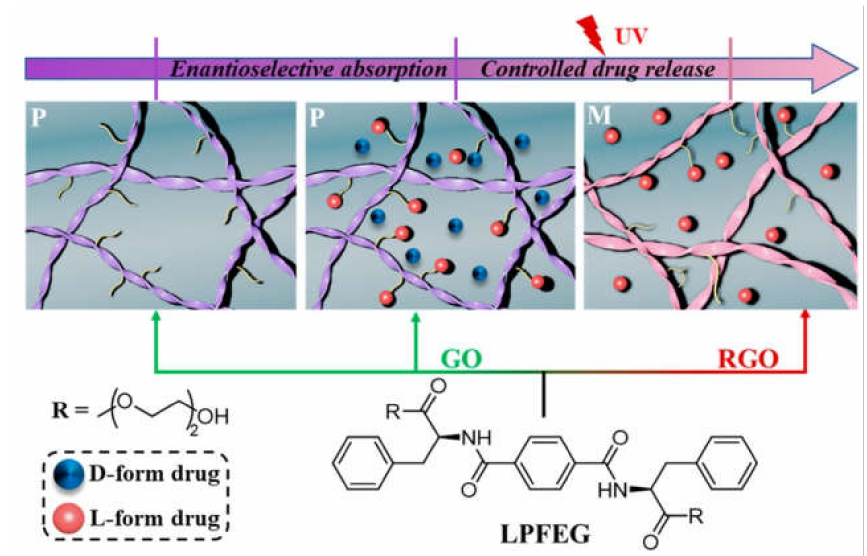
Figure 6. Photo-triggered drug release from a phenylalanine derived hydrogelator that self-assembles into helical nanoribbons on the surface of GO flakes and allows for enantioselective drug adsorp- tion. Reprinted with permission from Zhang, Y. et al. (2020) [98], Copyright © 2021 American Chemical